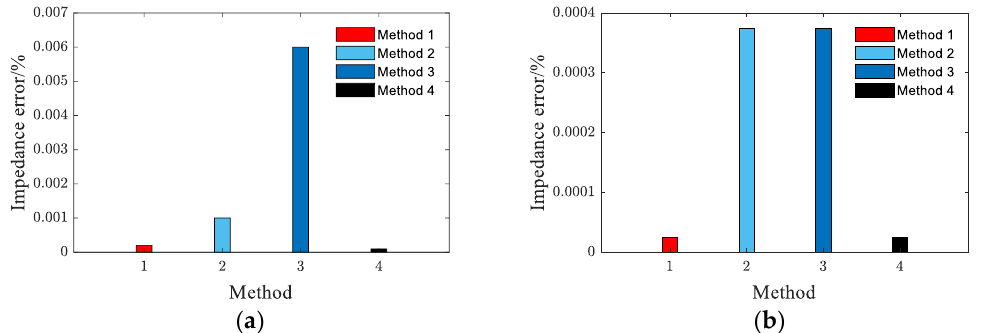
( b ) Figure 11. Results of method 3 in simulation II. ( a ) Result of real part; ( b ) Result of imaginary part. ( a ) ( b ) Figure 12. Results of method 4 in simulation II. ( a ) Result of real part; ( b ) Result of imaginary part. Comparing Figures 8 – 11, method 1 and method 4 are relatively stable. Although there are some outliers in the imaginary part of method 1, the fluctuation amplitude is still smaller than method 4, and the volatility of method 2 and method 3 is larger. To further highlight the superiority of the proposed method in this paper, the error histogram of several methods is drawn, in which the absolute value of the error is taken,